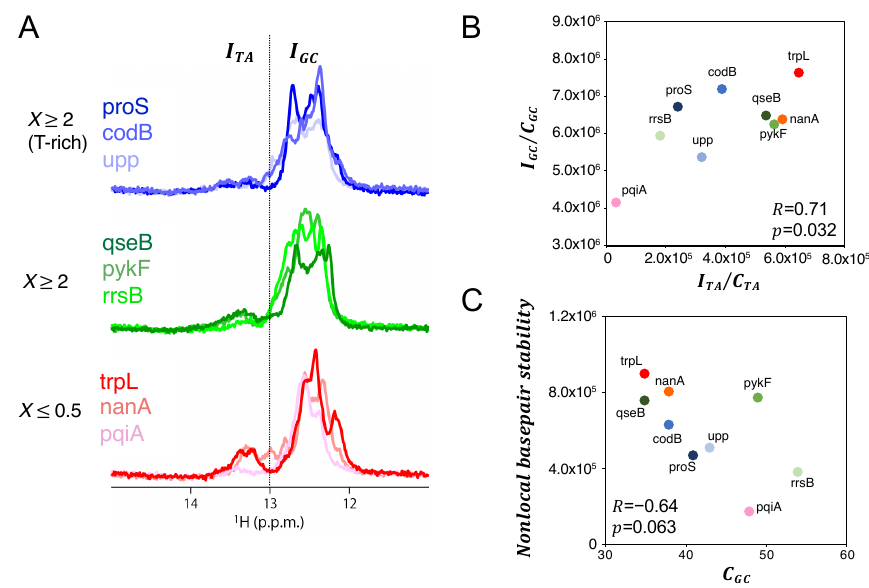
Figure 9. Solution NMR spectroscopy measuring imino proton resonances in 80-bp dsDNA with promoter sequences. ( A ) Proton NMR spectra of the promoter groups shown in Figure 6B. The dotted line represents the boundary between the imino proton signals that are derived from dT-dA base pair ( I TA ) and that from dG-dC base pairs ( I GC ). Larger integrated signal represents more stable base pairing over dsDNA, which is obtained from slower exchange of the imino proton with water proton. ( B ) Global correlation in the base-content-normalized imino proton resonances between dT-dA base pairs ( I TA / C TA ) and dG-dC base pairs ( I GC / C GC ) among 9 promoter DNA. ( C ) The nonlocal base pair stability tends to negatively correlate with GC contents ( C GC ) of promoter DNA. Pearson correlation coe ffi cient R and the p -value is shown in each graph of panels B and C.